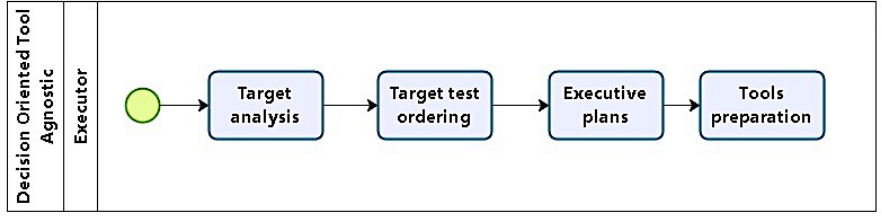
Figure 5. Phase 4: Tactical